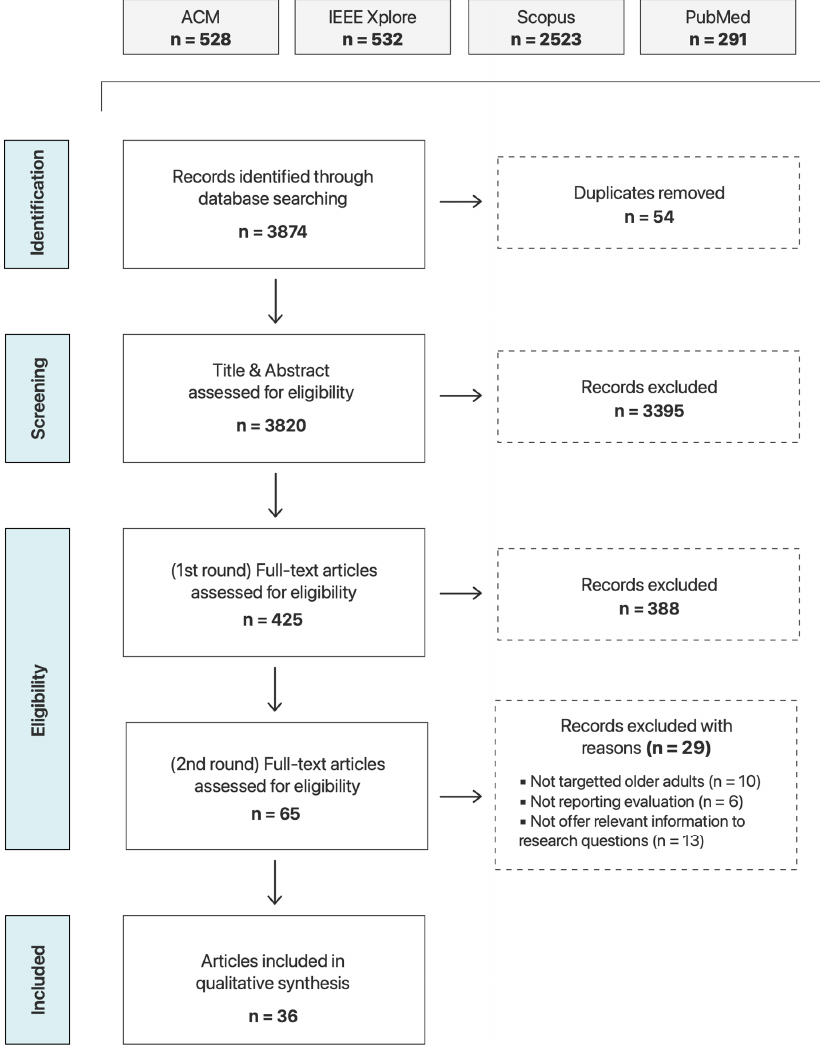
Figure 1. PRISMA flow